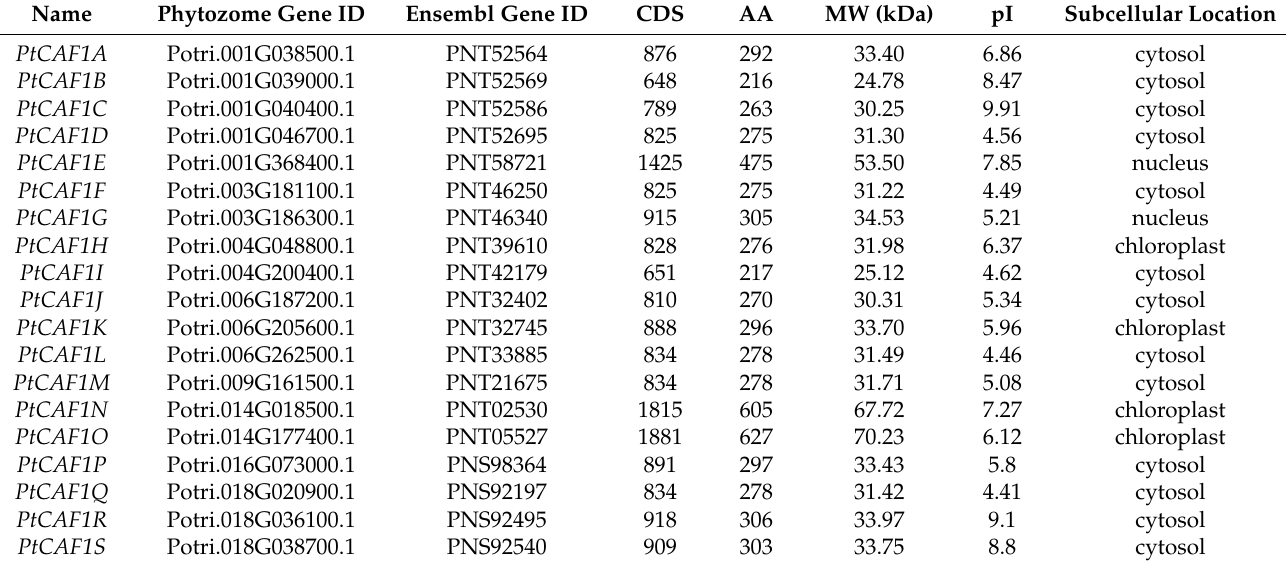
Table 1. List of 19 PtCAF1 genes and their basic